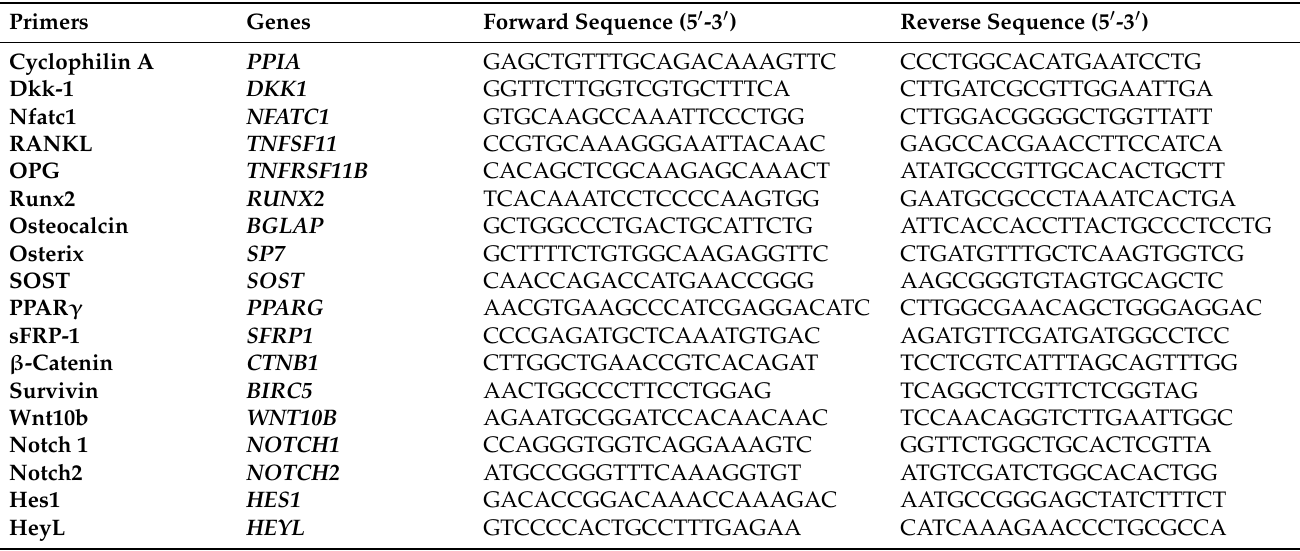
Table 1. Primers used in this